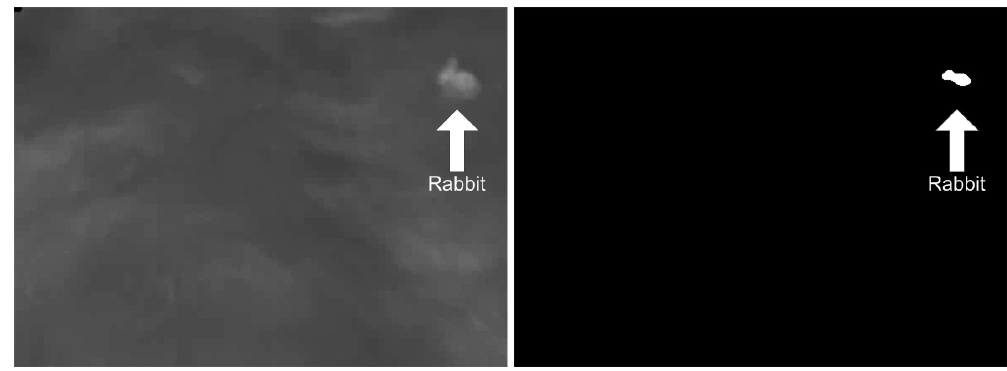
Figure 5. Example of binary image, where the rabbit is white (1) and the background is black (0). Figure 5 (left) shows the original image and Figure 5(right) shows the binary image where only the rabbit is visible.